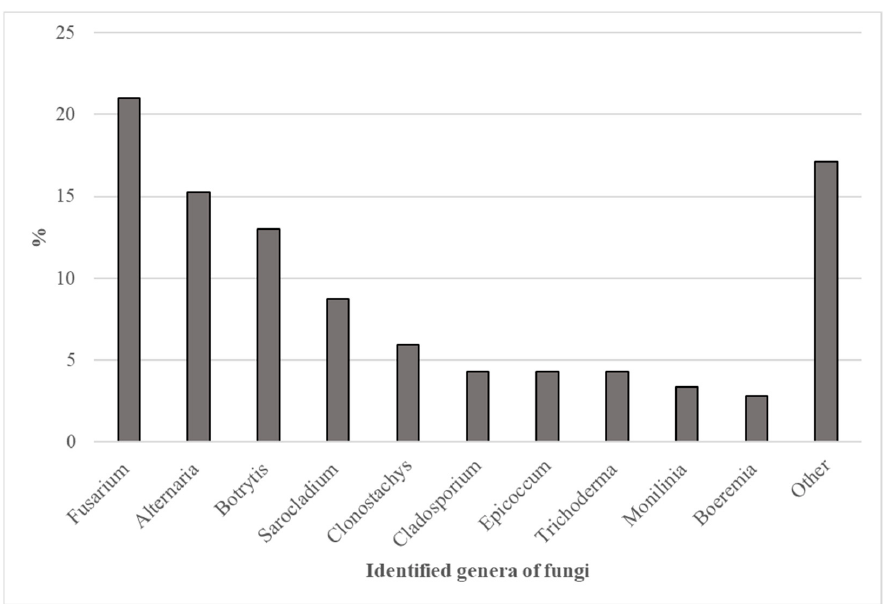
Figure 4. Relative density of the fungal genera obtained from C. japonica . Other includes Arthrinium, Diaporthe, Coniophora, Talaromyces, Akanthomyces, Didymella, Penicillium, Allantophomopsis, Aureobasidium, Neoascochyta, Sordaria, Neofabraea, Discosia, Pseudopithomyces, Truncatella, Trichothecium, Rhizoctonia, Trametes, Stagonosporopsis, Pestalotiopsis, Nigrospora, Rosellinia, Hormographiella, and Isaria